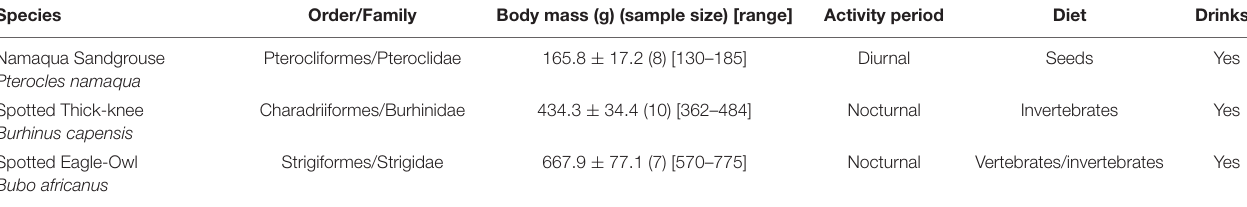
TABLE 1 | Taxonomy, body mass, activity period, major diet and water dependence of the three study species.